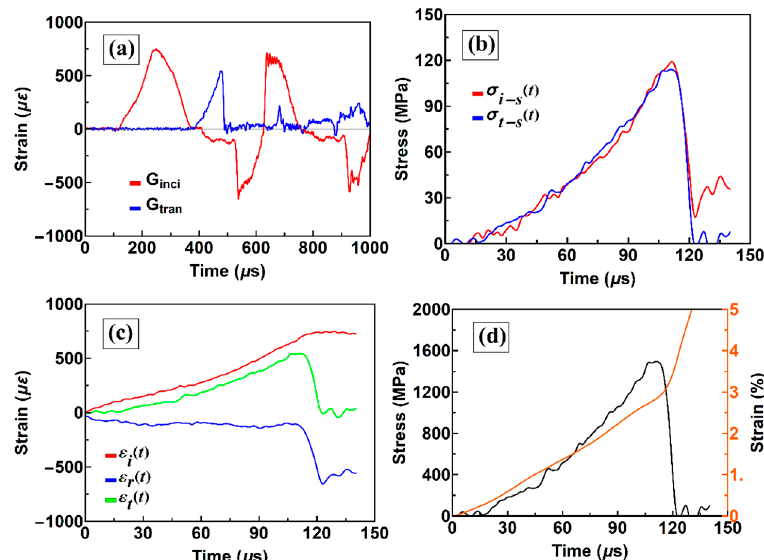
Figure 3. Typical signals of a conventional SHPB: ( a ) original stress signals from two incident and transmission gauges; ( b ) interface stress between the bar and sample; ( c ) incident, reflected, and transmission waves, and ( d ) stress and strain history curves of the sample.